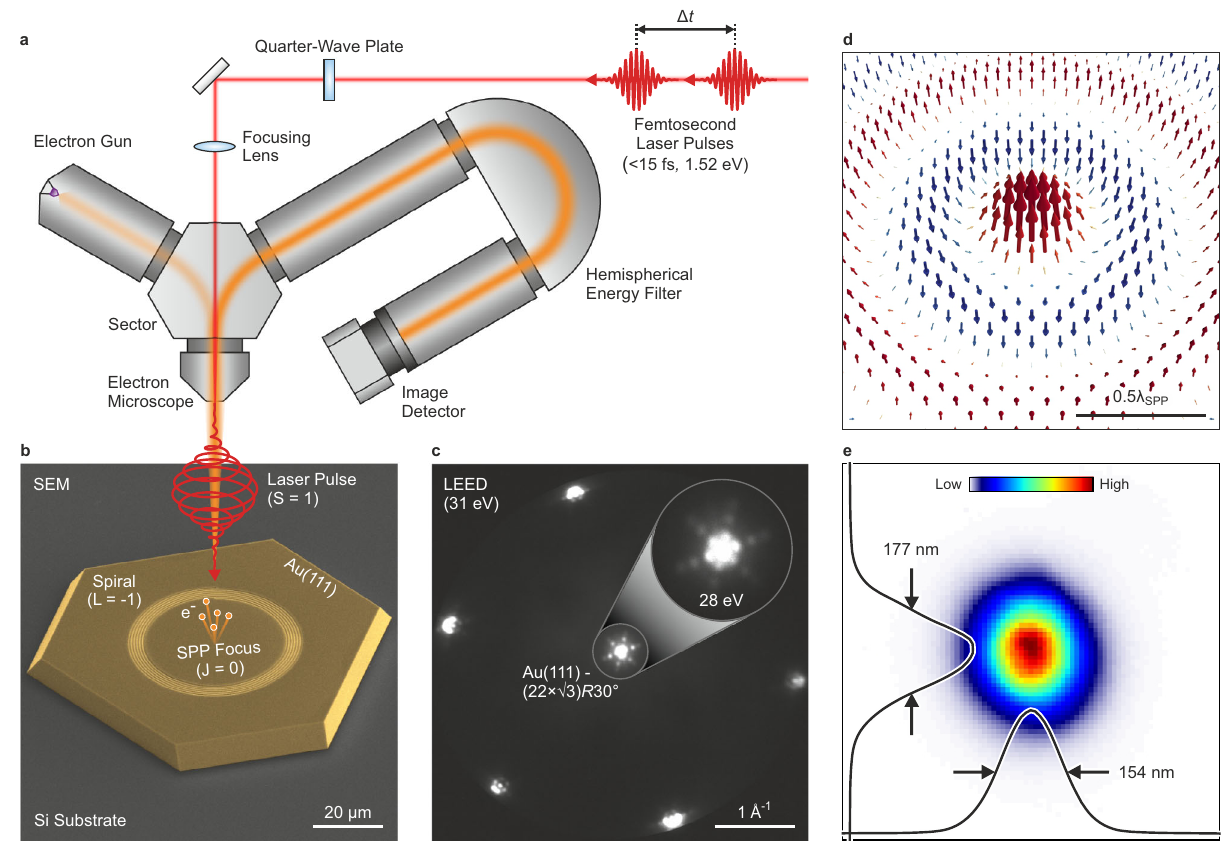
Fig. 1 Electron emission from nano-focused surface plasmon polariton pulses. a Sketch of the electron microscopy setup. Femtosecond laser pulses impinge on the sample surface along the surface normal. The emitted electrons are dispersed in an imaging energy fi lter and detected using a CMOS detector. b Scanning electron micrograph (SEM) of an Archimedean spiral like the ones used for the presented results. Upon excitation of the spiral with a circularly polarized laser pulse a surface plasmon polariton (SPP) nano-focus is formed in the center of the spiral. c Typical low-energy electron diffraction (LEED) pattern acquired after sample preparation in the microscope. d Plot of the calculated electric fi eld vectors in the center of the Archimedean spiral. e Photoemission electron microscopy (PEEM) image of the spatial distribution of the photoelectrons that are emitted from the center of the Archimedean spiral in a linear false color scale (see color bar in panel e ). The marginal distributions are plotted (black lines) and their respective full width at half maximum is